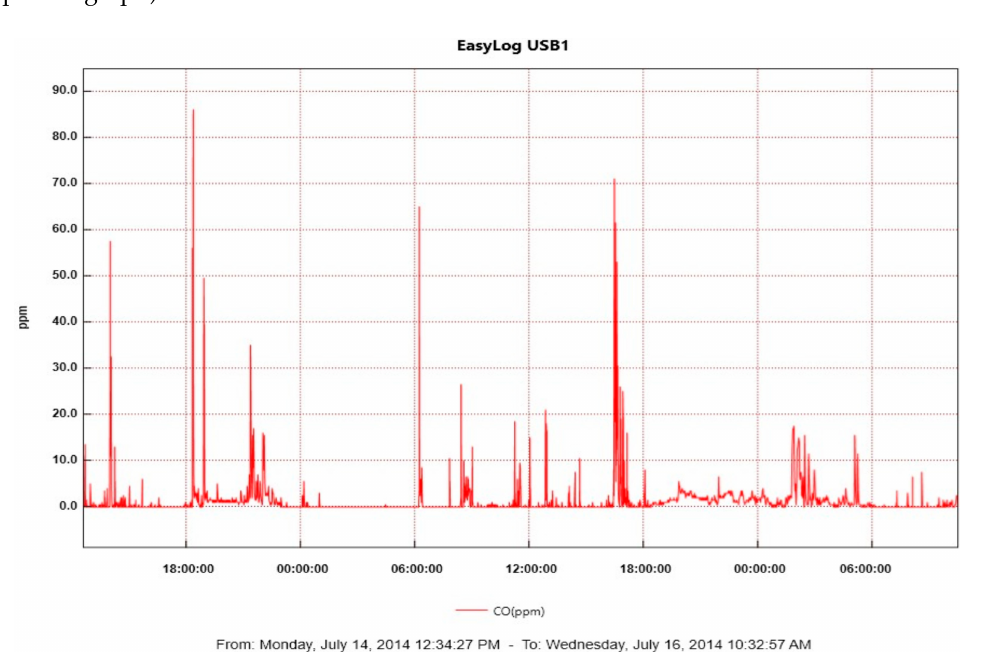
Figure 3. Example of CO exposure graph from Lascar CO